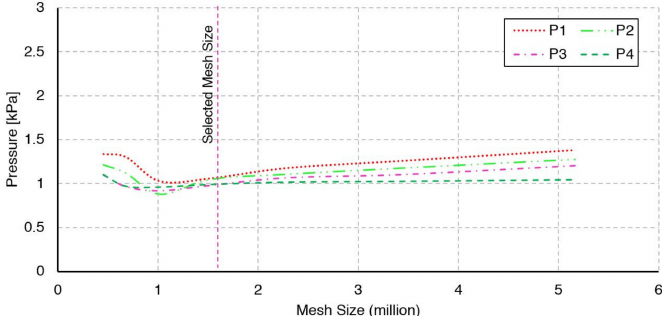
Figure 4. Mesh Independent Test.